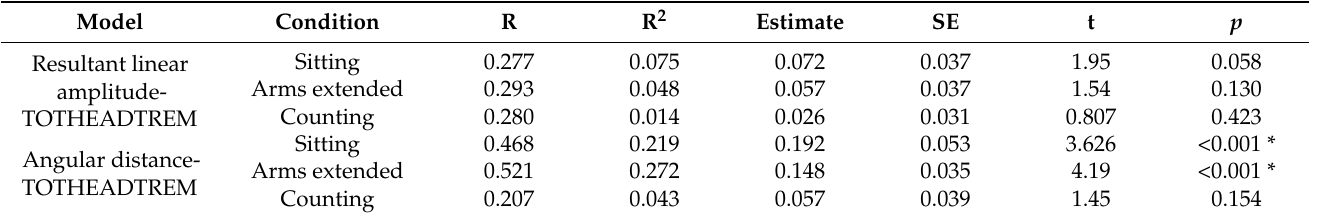
Table 2. Summary of the Spearman rank correlation analysis between head tremor severity (TOT- HEADTREM) and log-transformed values of linear and angular amplitude of head tremor.